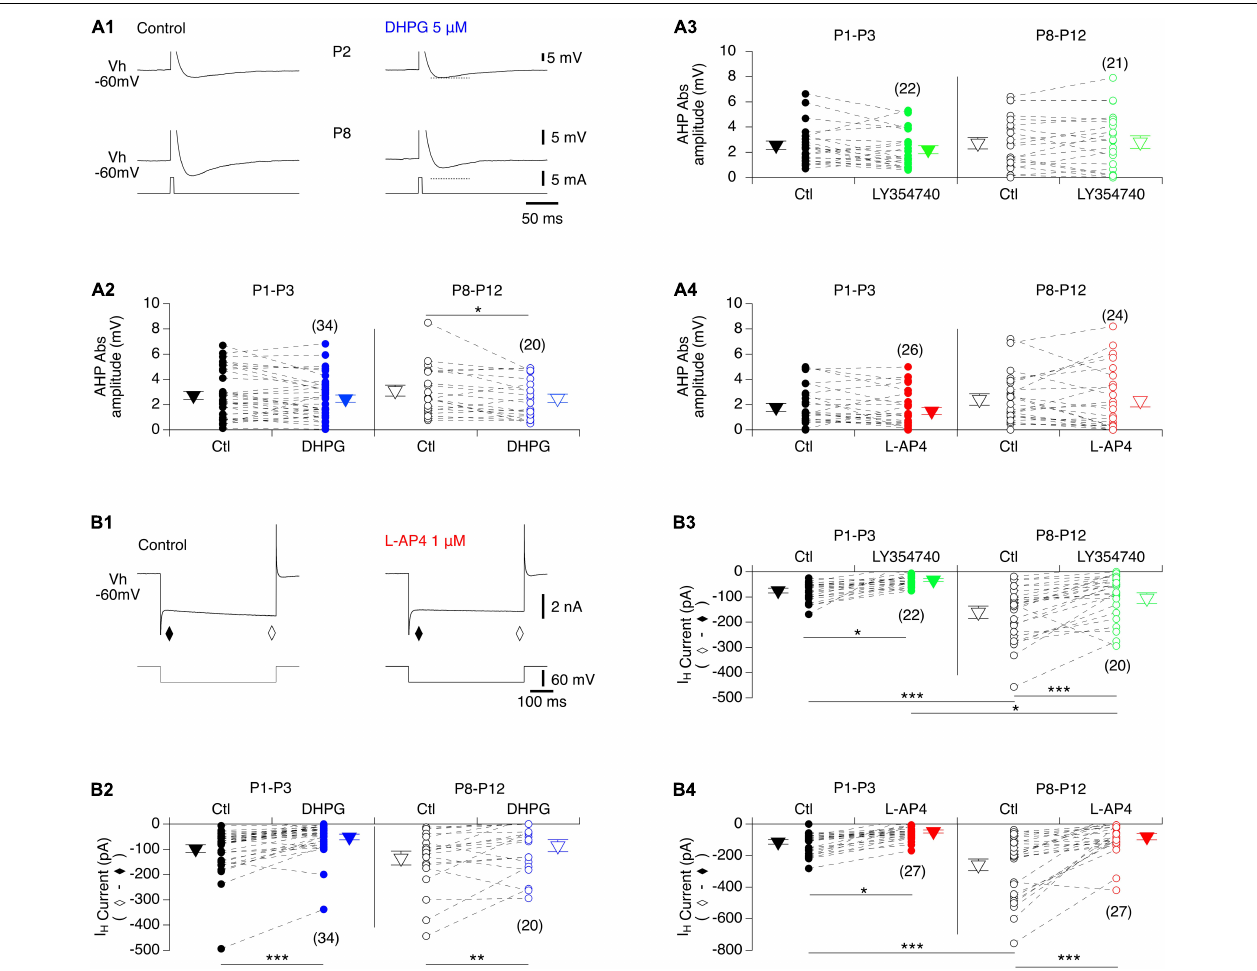
FIGURE 5 | Actions of mGluR agonists on AHP and I H current in lumbar MNs. (A) Representative AHPs expressed after an action potential induced by a brief current pulse injected into a P2 ( A1 , top panel) and a P8 ( A1 , bottom panel) MN in control condition ( A1 , left) and in the presence of DHGP ( A1 , right) held at –60 mV (Vh –60 mV). The action potentials have been truncated for better visualization of the AHPs. Dashed lines correspond to the value of AHP amplitude in control. (A2–A4) Scatter plots with connecting lines (dashed) of absolute mean AHP amplitudes computed in P1-P3 (filled circles) and P8-P10 MNs (open circles) before (black circles) and after exposure to DHPG (blue circles, A2 ), LY354740 (green circles, A3 ) or L-AP4 (red circles, A4 ). Note that AHP amplitudes were significantly decreased only in the presence of DHPG in P8-P12 MNs. (B) Sample membrane current traces obtained in response to a voltage step of –60 mV in a MN held at –60 mV (Vh –60 mV) in voltage clamp conditions before (control) and after exposure to L-AP4 on the slice (B1) . The I H current was computed by subtracting the instantaneous current ( τ ) from the steady state ( ♦ ). Regardless of age, all three mGluR agonists caused a significant blockage of the I H current. (B2–B4) Scatter plots with connecting lines (dashed) of the I H current in P1-P3 (filled circles) and P8-P10 MNs (open circles) before (black circles) and after exposure to DHPG (blue circles, B2 ), LY354740 (green circles, B3 ) or L-AP4 (red circles, B4 ). The triangles correspond to means ± sem of the population tested in each condition and numbers in parentheses to the number of MNs tested. Two-way RM ANOVA followed by Sidak’s post hoc tests, * p < 0.05; ** p < 0.01 and *** p < 0.001 significantly